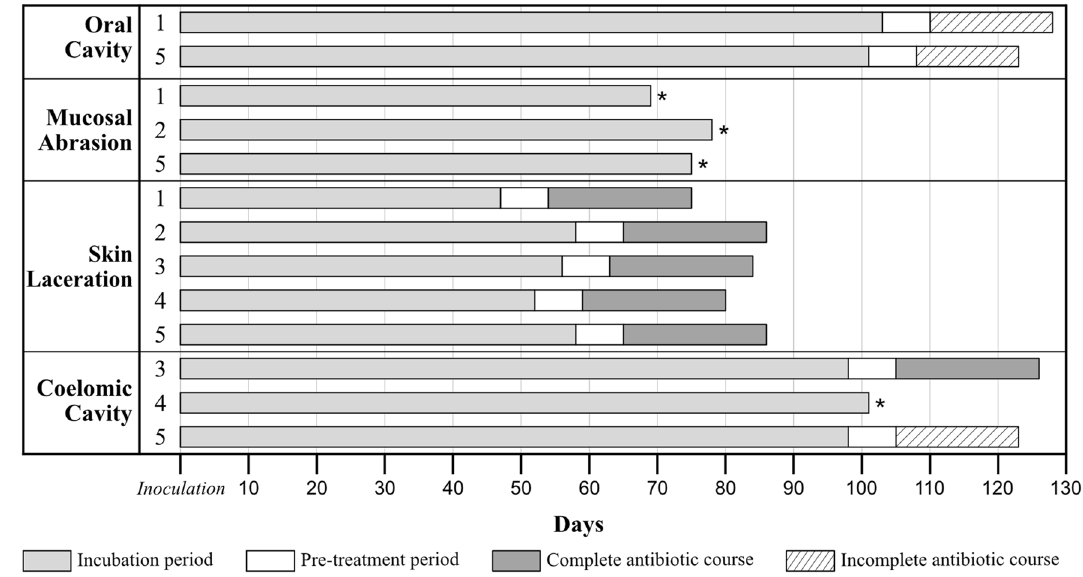
Figure 2. Bar chart illustrating the incubation period, pre-treatment period (period from confirmation of infection and onset of treatment), and treatment duration as a function of route of E. lacertideformus inoculation. White, light grey, dark grey, and hatch represent the pre-treatment period, incubation period, complete antibiotic course, and incomplete antibiotic course, respectively. * indicates a gecko that did not receive antibiotic treatment due to logistical limitations. Note this diagram does not include geckos in the subcutaneous inoculation group (SuC) and naturally infected geckos (NaI) as they did not develop clinical disease